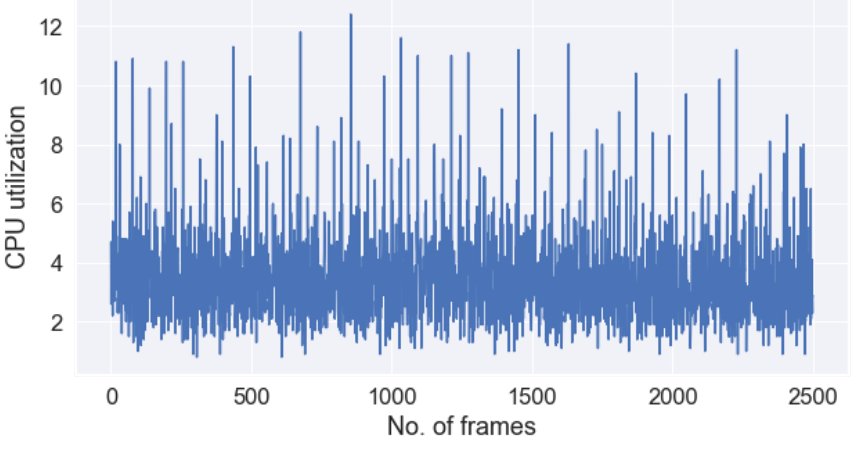
Figure 8. CPU utilization in standalone machine after OpenStack installation.